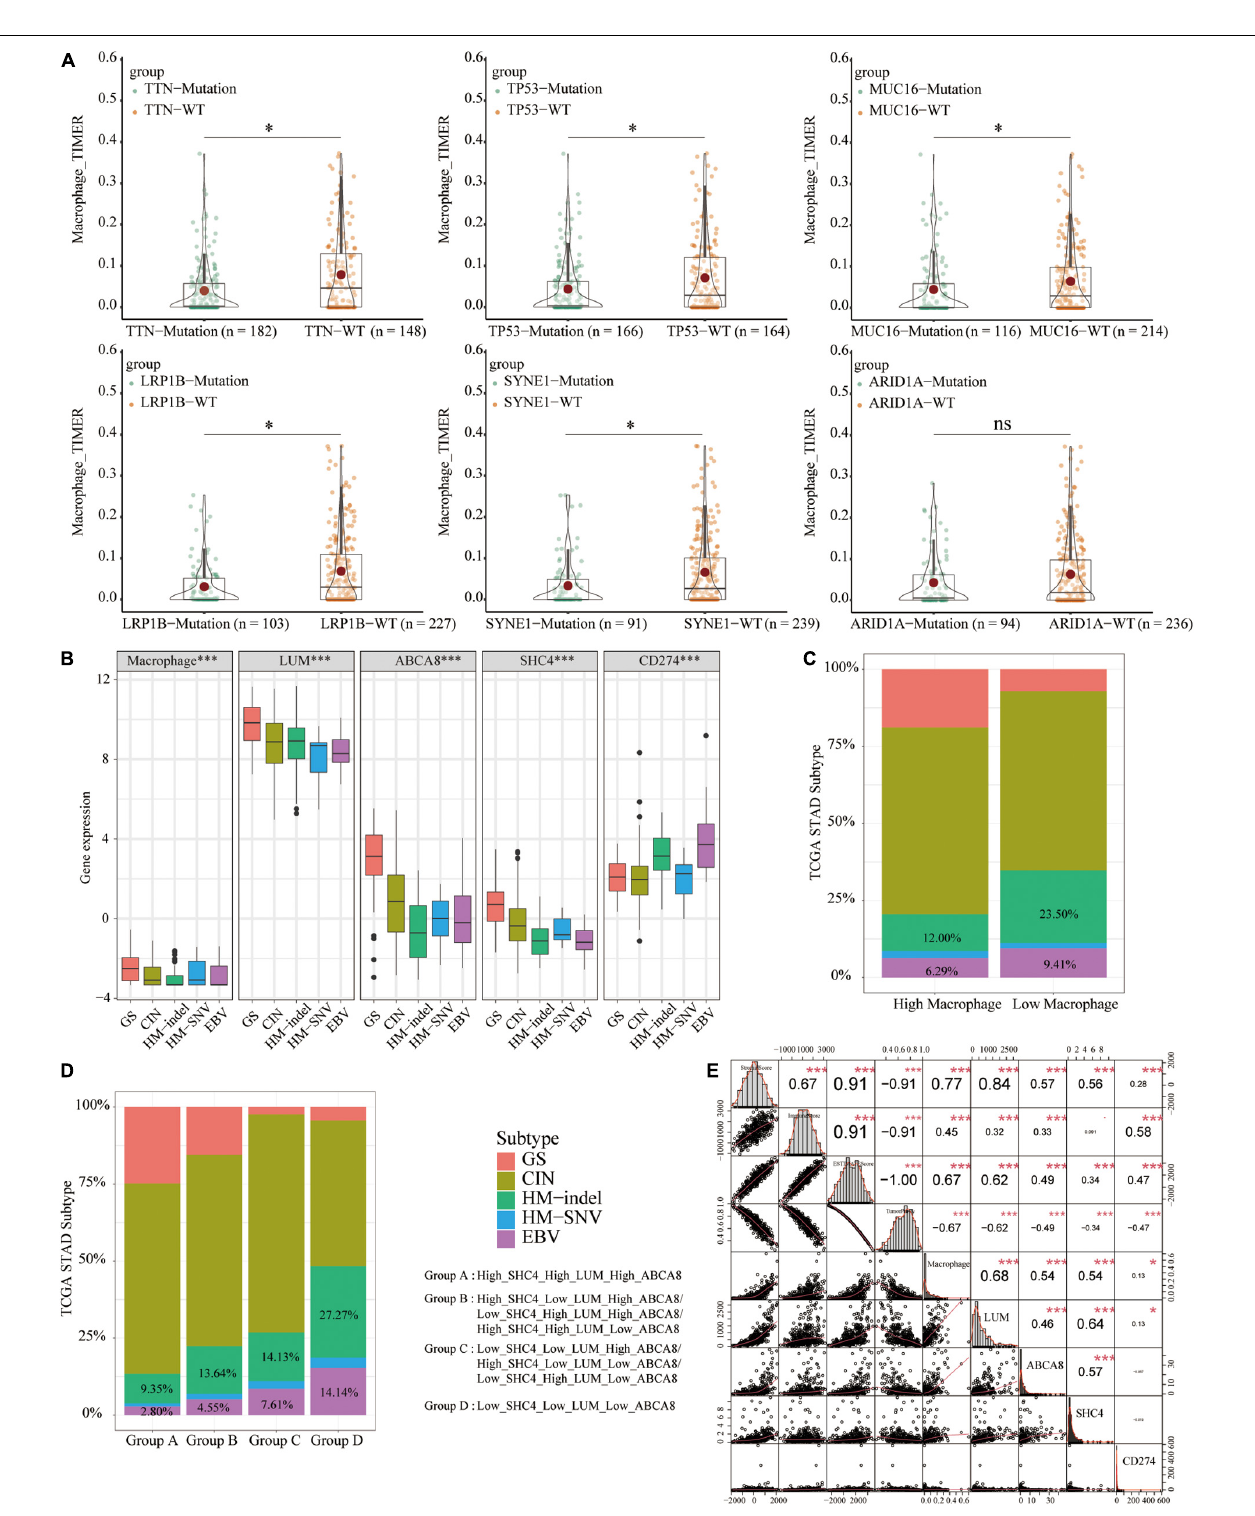
FIGURE 10 | Differences in the abundance of macrophages and 3 key genes and the correlation of tumor microenvironment score. (A) Among the 6 most frequently mutated genes, TTN/TP53/MUC16/LRP1B/SYNE1-mutant tissues had significantly lower macrophage abundance than WT tissues. (B) The EBV and HM-indel subtypes had lower macrophage abundance, expression of 3 key genes and higher expression of PD-L1. (C) STAD tissues in the low macrophage group had a higher proportion of HM-indel and EBV. (D) From group A to group D, the proportion of HM-indel and EBV significantly increased. (E) Macrophage abundance, 3 key genes and PD-L1 were all negatively correlated with tumor purity and positively correlated with stromal scores. * p < 0.05, *** p < 0.001.